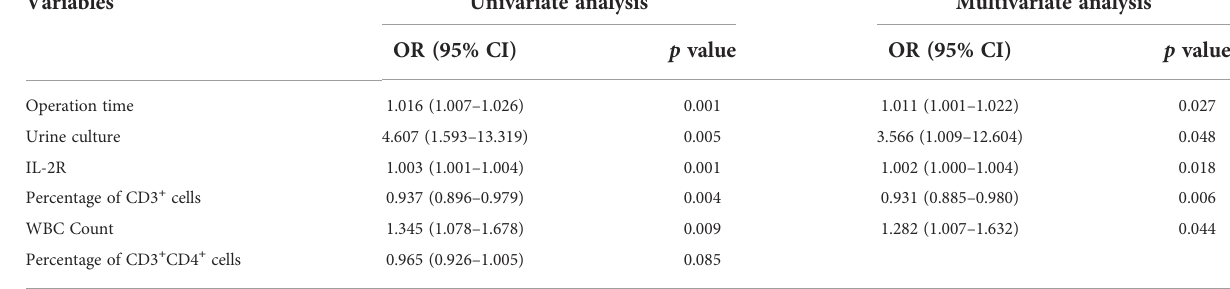
TABLE 3 Univariate and multivariate analyses of risk factors for SIRS.